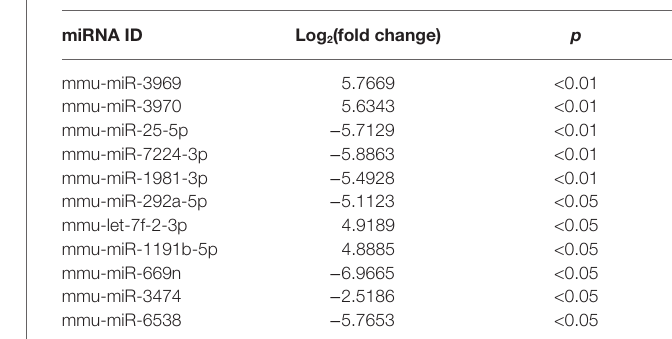
TABLE 1 | Differentially expressed miRNAs in EVs from HG-podo group compared to NG-podo group.